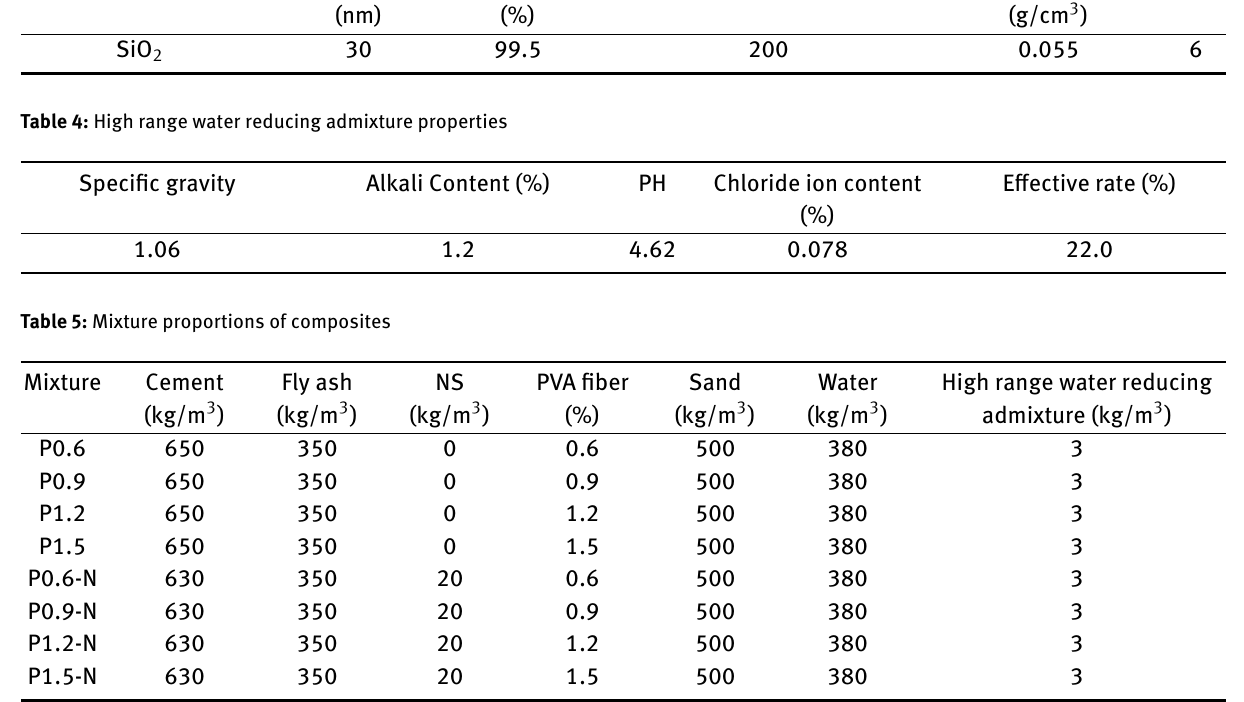
Table 3: Basic properties of nanoparticles Nano particles